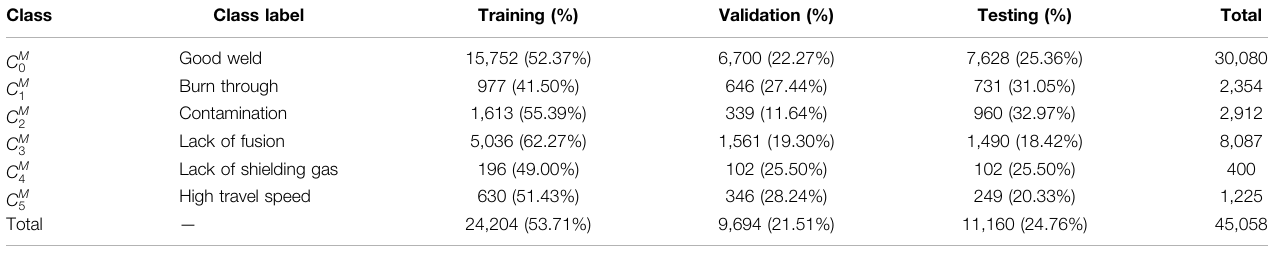
TABLE 4 | Data distribution of the welding data set for multi-class classi fi cation.